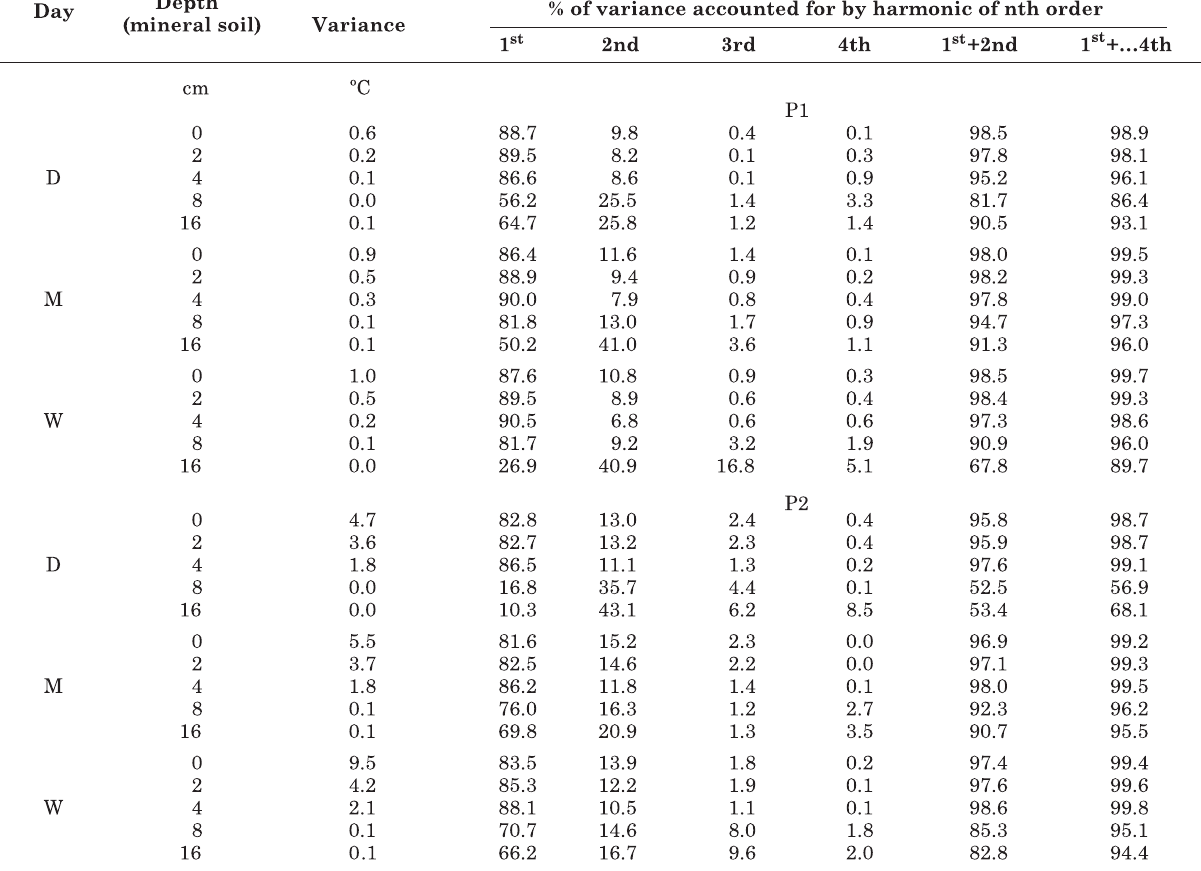
Table 4. Total variance of soil temperature in P1 and P2 mineral soil profiles on days D (dry soil), M (moist soil) and W (wet soil) in a pine-forested Haplic Podzol, and the percentage accounted for by the first four Fourier harmonics